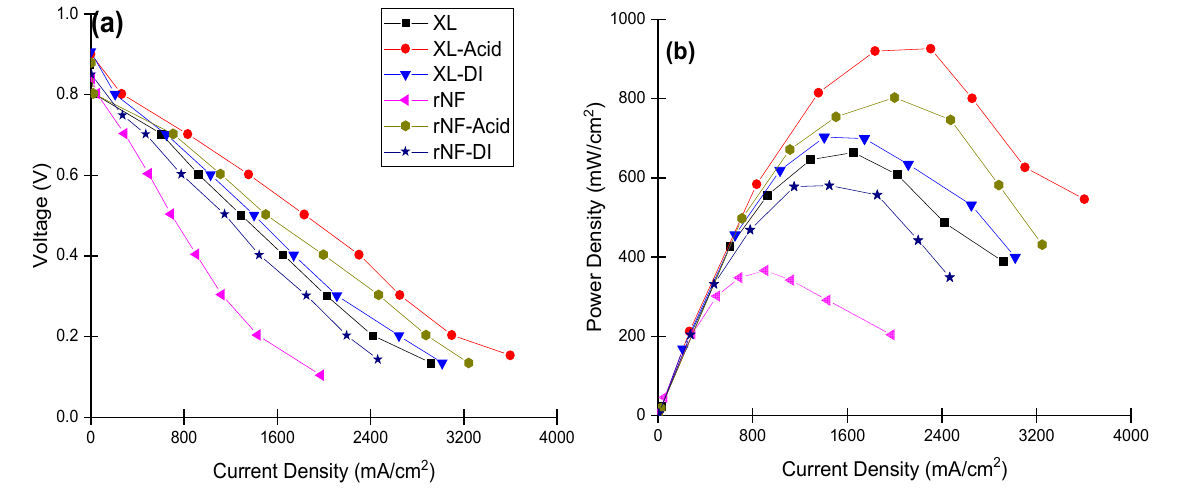
Figure 3. I-V ( a ) and power density ( b ) curves for all the membranes at 80 °C and relative humidity of 50%, 30% for H 2 and O 2 , respectively. Single cell efficiency was investigated by varying the operating temperature between 25 and 60 ◦ C. Maximum power densities were obtained from the power density curves while the current densities were evaluated at 0.4 V from the polarization curves recorded according to the New European Driving Cycle protocol [43] and results are plotted in Figure 4.